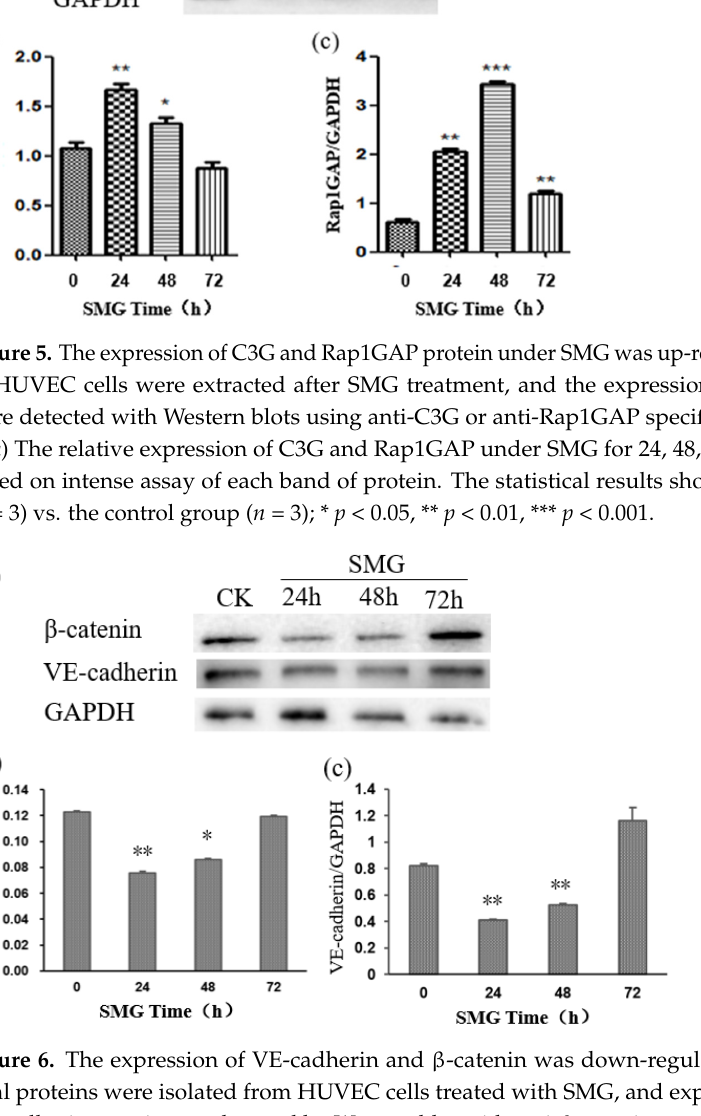
Figure 7. T he expression and distribution of VE-cadherin and β -catenin in HUVEC cells under SMG. The upper panel: VE-cadherin in green; the middle panel: β -catenin in red; the lower panel: merged. The white arrows shows the location of VE-cadherin (first line), β -catenin (second line) and the co- localization of VE-cadherin and β -catenin. Scale bar = 20 µ m.